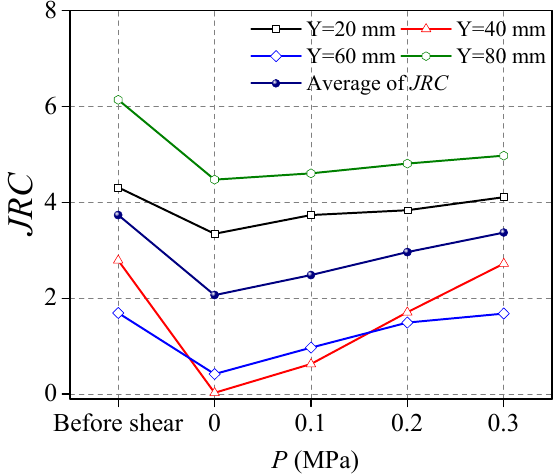
Figure 8. JRC value of the contour line at different Y values.